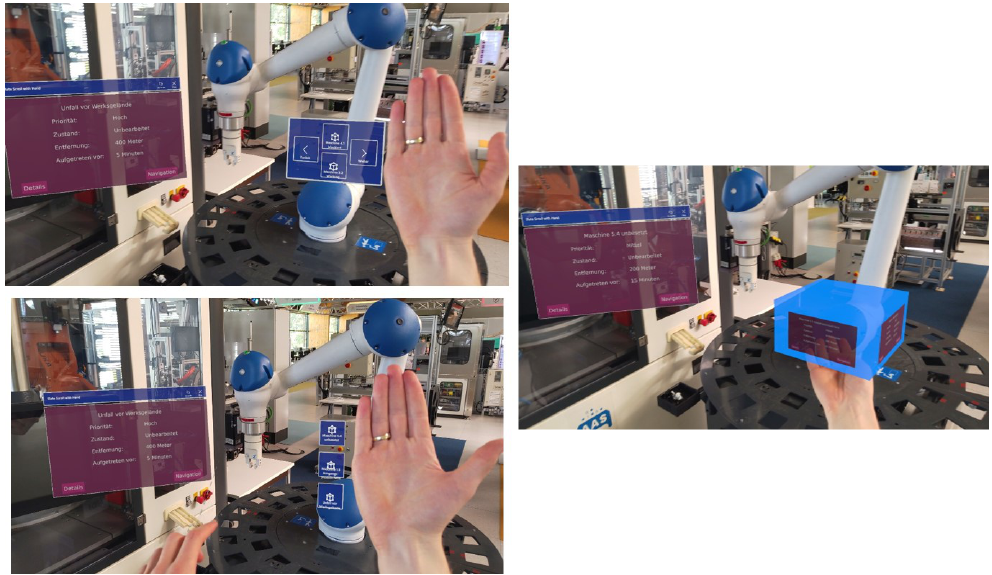
Figure 6. View of the three variations for our hand menu evaluation. Upper left: click menu; lower left: scroll menu; right: cube